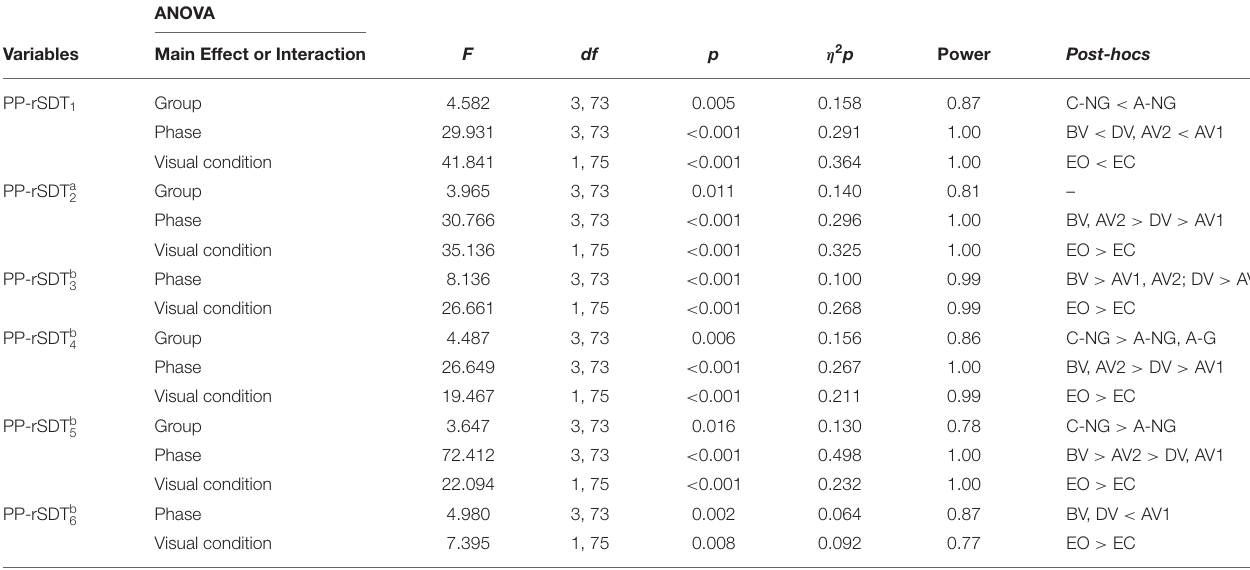
TABLE 2 | Significant results from the four (Group) x four (Phase) x two (Visual condition) ANOVAs in the principal postural movement components (PP). ANOVA